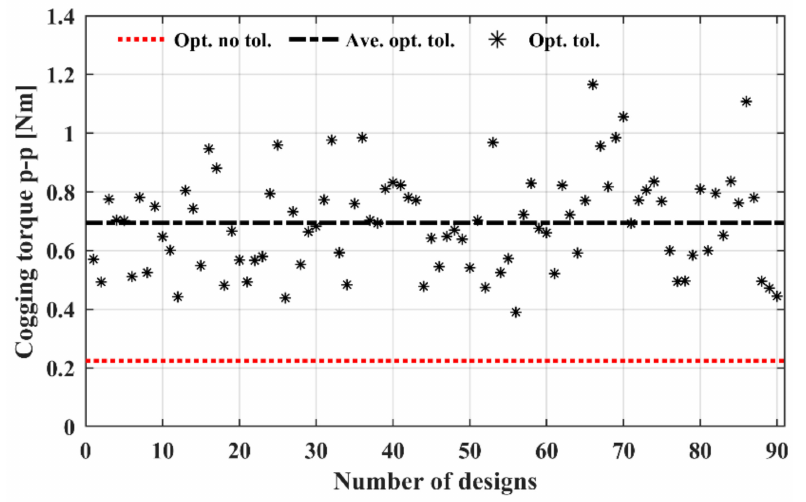
Figure 17. Peak-to-peak cogging torque of the optimized APMM with 20 stator segments under manufacturing and assembling